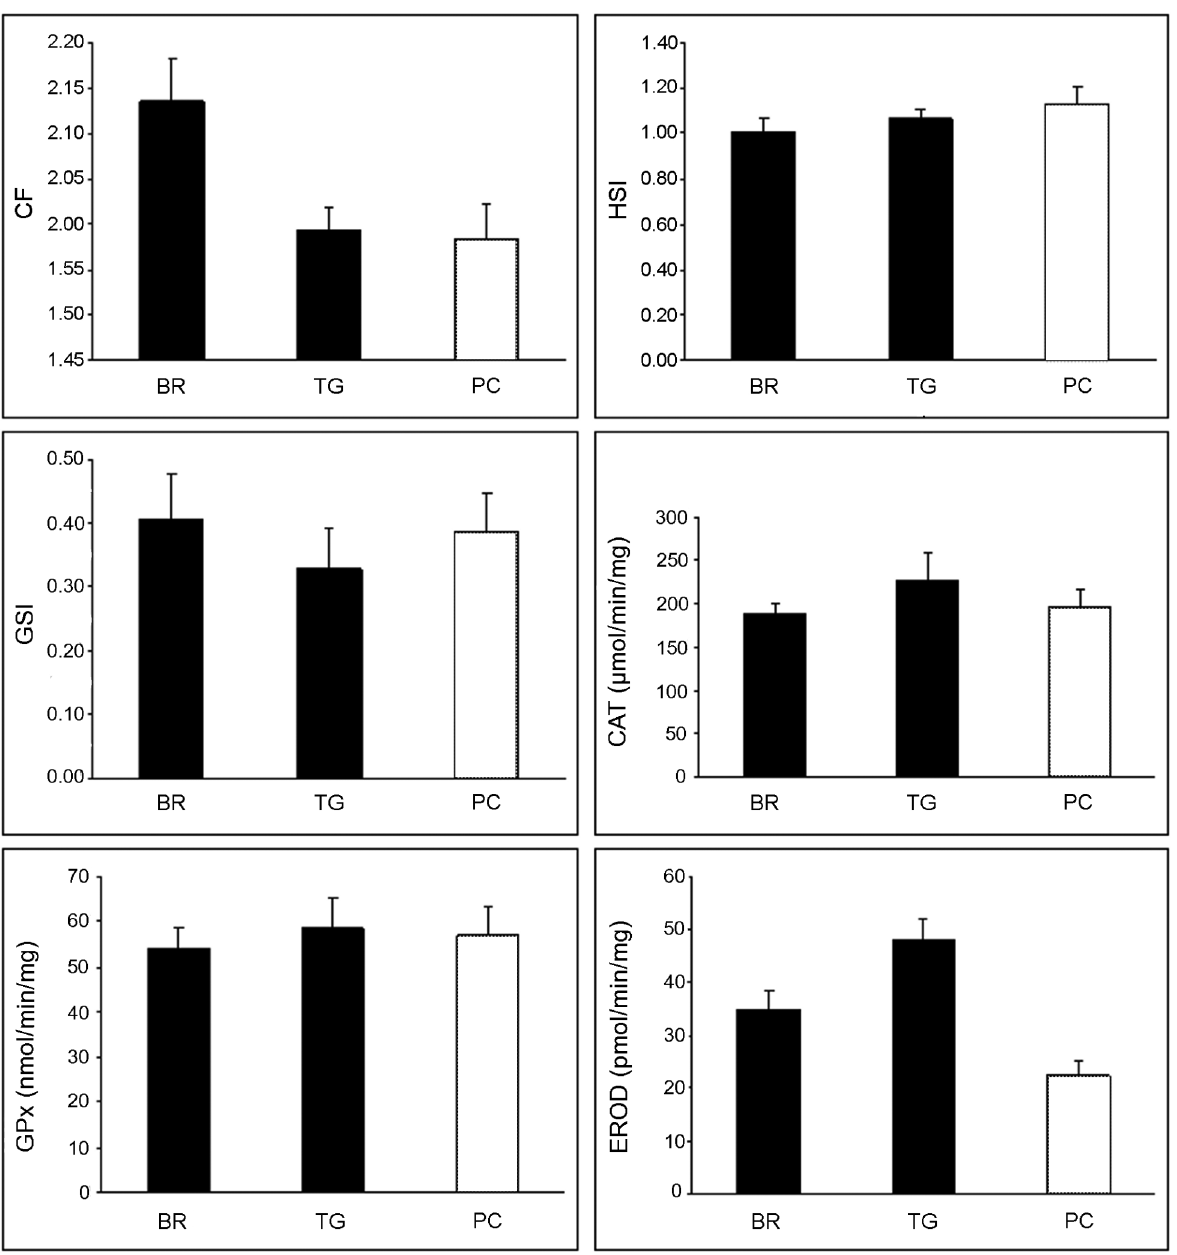
Figure 2. General condition markers and antioxidant biomarkers mean values for three study locations. Mean ( 6 SE, n=15) of general condition markers (CF, HSI and GSI), antioxidant biomarkers (CAT and GPx) and activity of EROD were represented as a black bar for fish speared in the invaded locations (BR and TG) and white for non invaded area (PC).